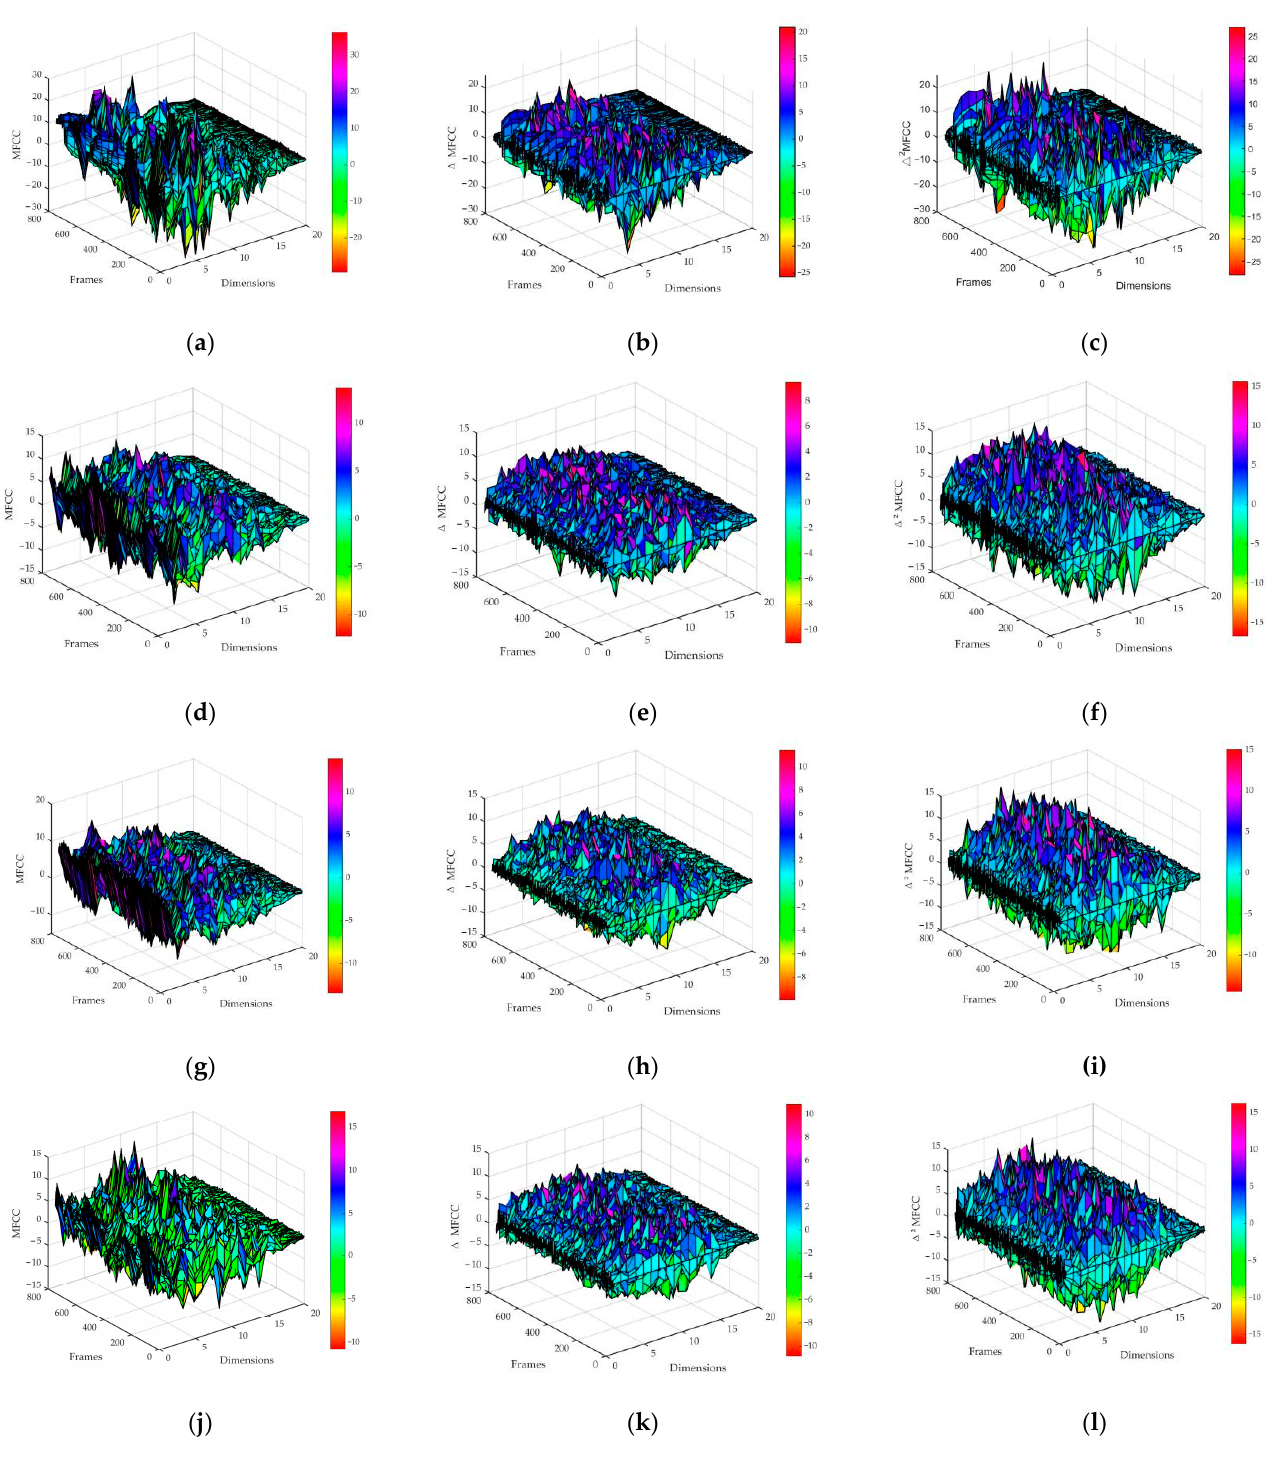
Figure 6. MFCC 3D diagram of pig sound signal. ( a ) Pig cough sound MFCC; ( b ) pig cough sound ∆ MFCC; ( c ) pig cough sound ∆ 2 MFCC; ( d ) non-pig cough sound 1 MFCC; ( e ) non-pig cough sound 1 ∆ MFCC; ( f ) non-pig cough sound 1 ∆ 2 MFCC; ( g ) non-pig cough sound 2 MFCC; ( h ) non-pig cough sound 2 ∆ MFCC; ( i ) non-pig cough sound 2 ∆ 2 MFCC; ( j ) non-pig cough sound 3 MFCC; ( k ) non-pig cough sound 3 ∆ MFCC; ( l ) non-pig cough sound 3 ∆ 2